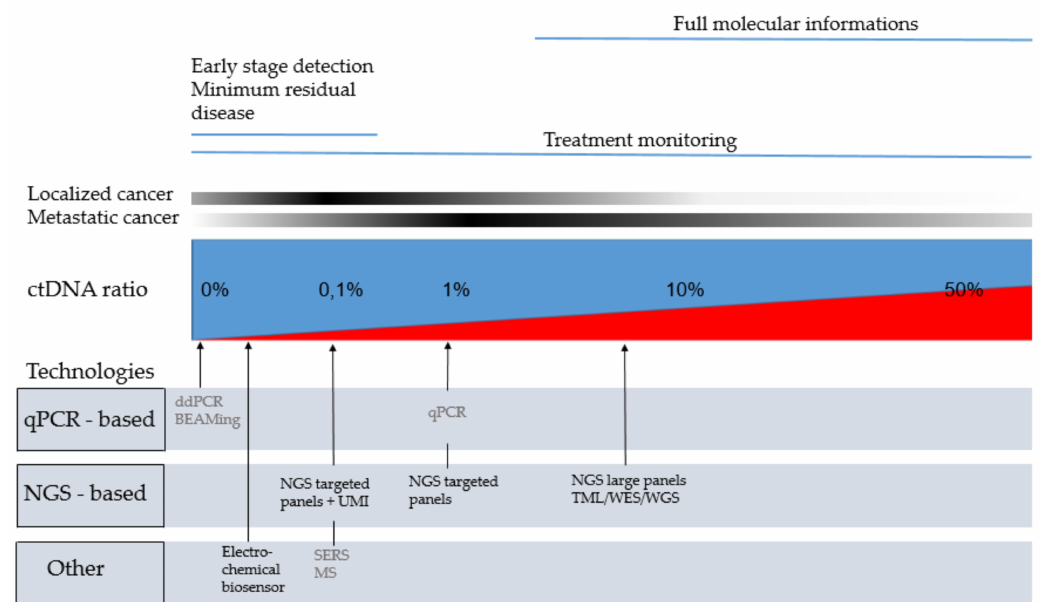
Figure 1. Technologies that can be use regarding ctDNA ratio and the clinical application. In grey: technologies with limited targets suggesting prior knowledge of the mutation; In black: technologies with broad genes coverage; In blue: non tumoral cell free DNA. In red: circulating tumor DNA; BEAMing: beads, emulsion, amplification, magnetics; ctDNA: circulating tumor DNA; ddPCR: digital droplet PCR; MS: Mass spectrometry; NGS: new generation sequencing; qPCR: quantitative PCR; SERS: Surface-Enhanced Raman Scattering; TLM: tumor mutation load; UMI: unique molecular identifiers; WES: whole exome sequencing; WGS: whole exome